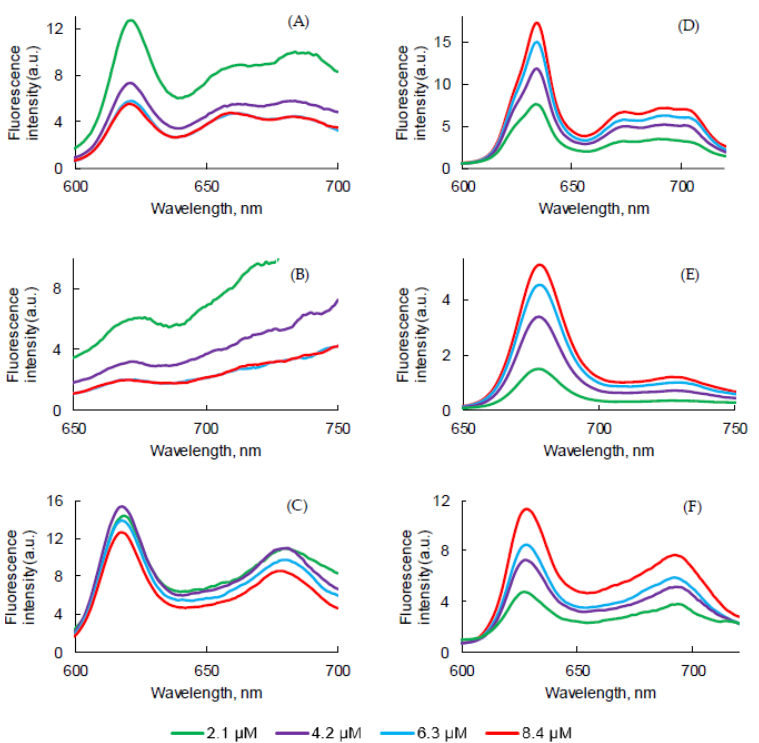
Figure 9. Fluorescence emission spectra ( λ exc = 400 nm for PpIX, PF and 415 nm for PPa) of PpIX ( A , D ), PPa ( B , E ), and PF ( C , F ) in PBS ( A – C ) and FBS ( D – F ) at different concentrations.